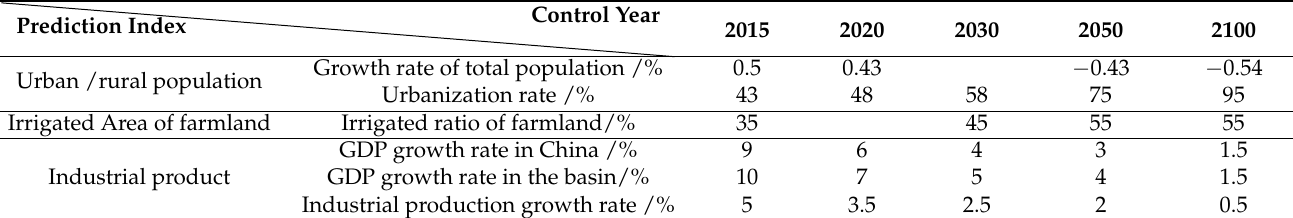
Table 4. Social-economic control years and